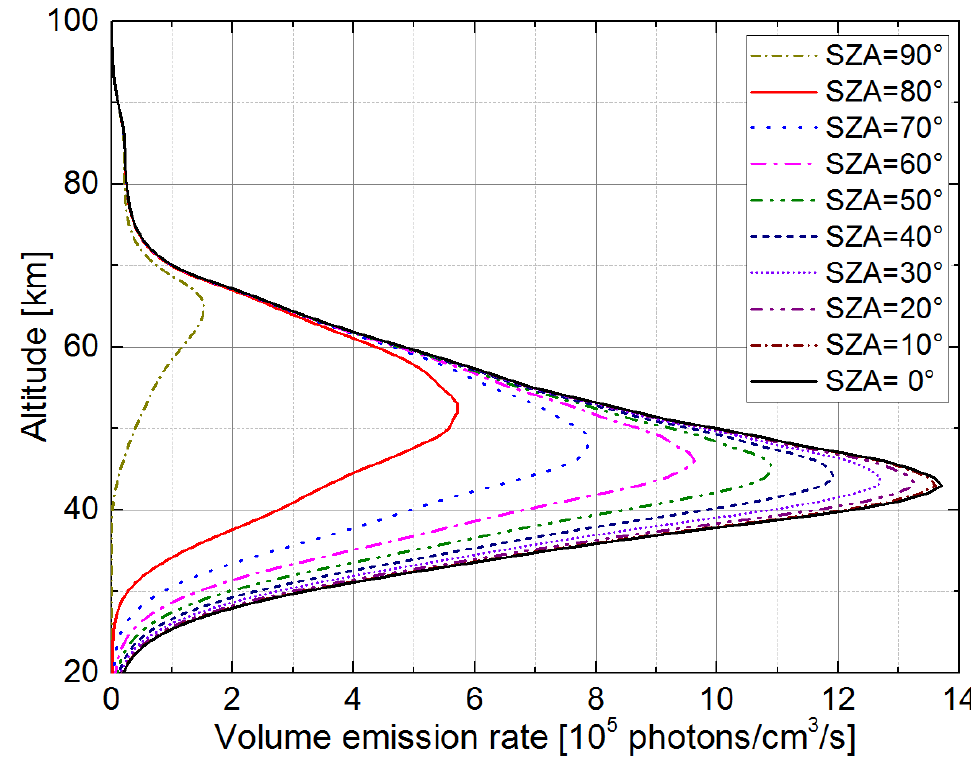
Figure 3. Calculated VER profiles of O 2 airglow at 1.27 µ m. Ten profiles were drawn at SZAs from 0° to 90° with an interval of 10°.